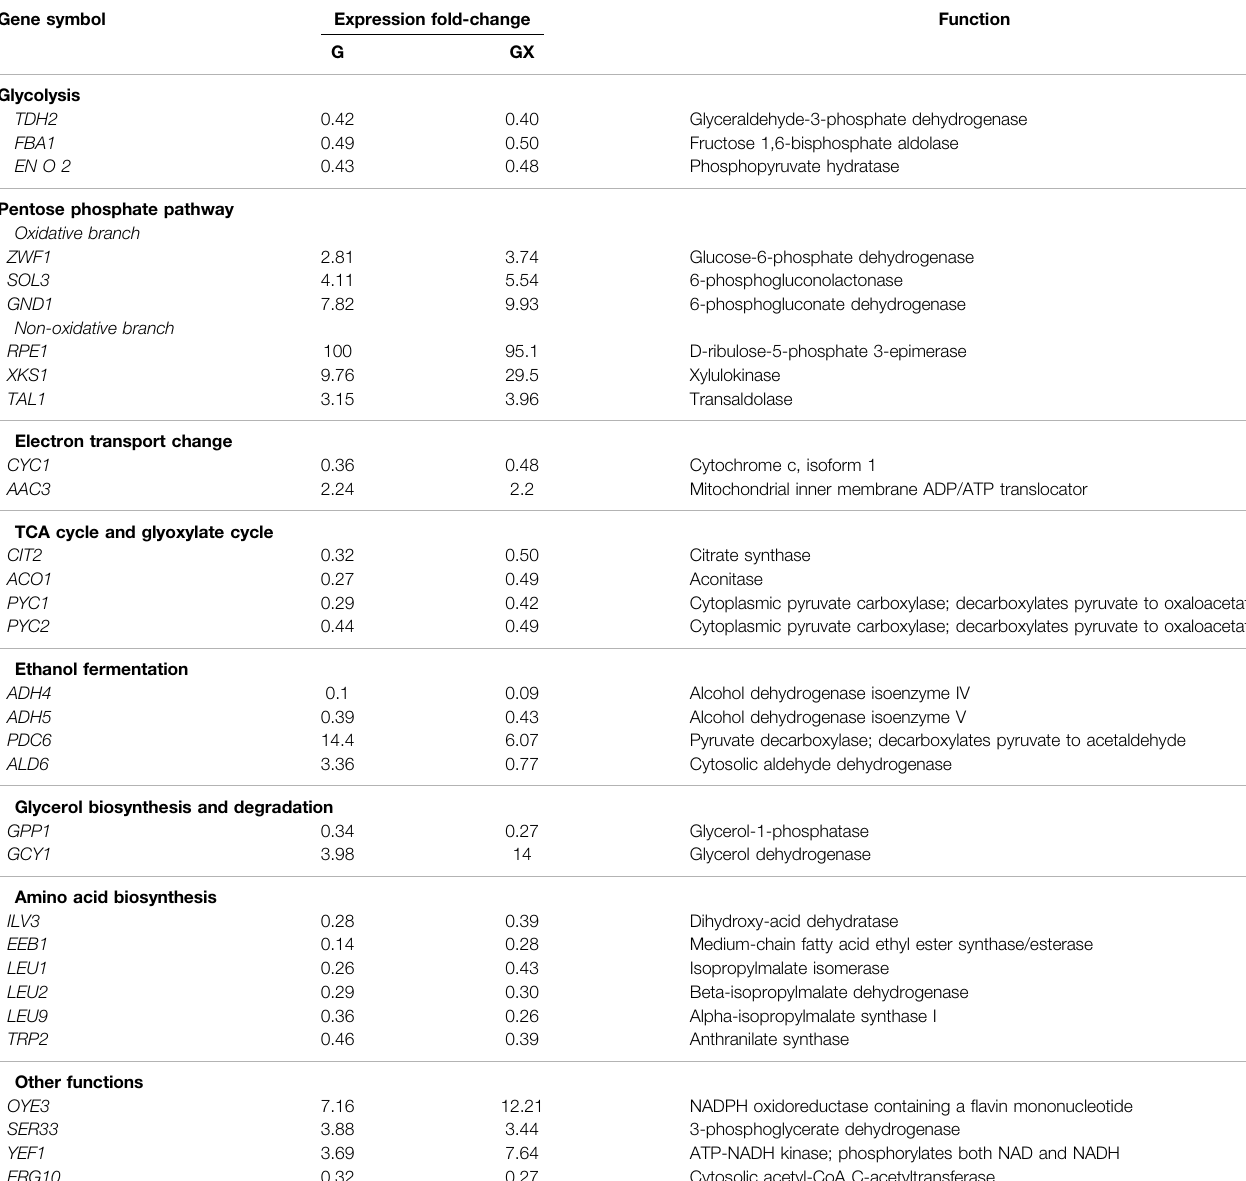
TABLE 3 | Fold-changes in the expression levels of genes involved in metabolic pathways in XUSEA-B strain, versus the WT-B strain. G: glucose, GX: glucose and xylose. Gene symbol Expression fold-change Function G GX Glycolysis